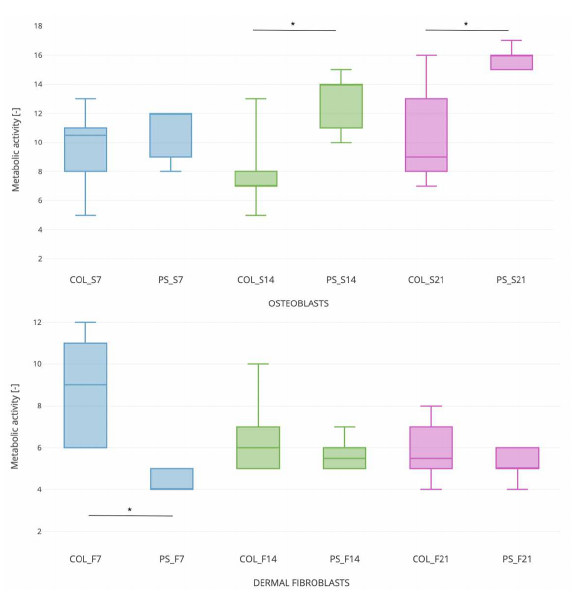
Figure 2. Metabolic activity of dermal fibroblasts and osteoblasts grown on COL and PS, * indicates statistically significant differences ( p = 0 . 05, t-test)